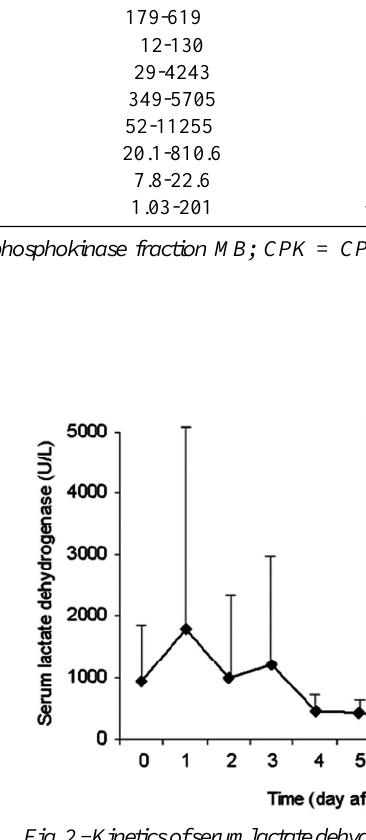
Fig. 2 - Kinetics of serum lactate dehydrogenase after myocardial rupture